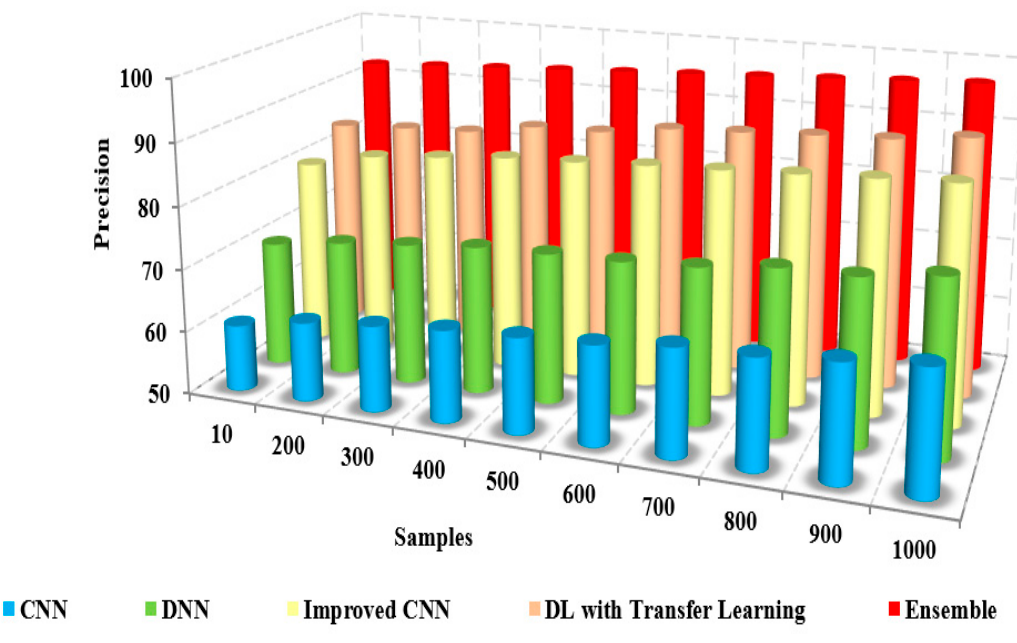
Figure 9. Samples vs. precision.